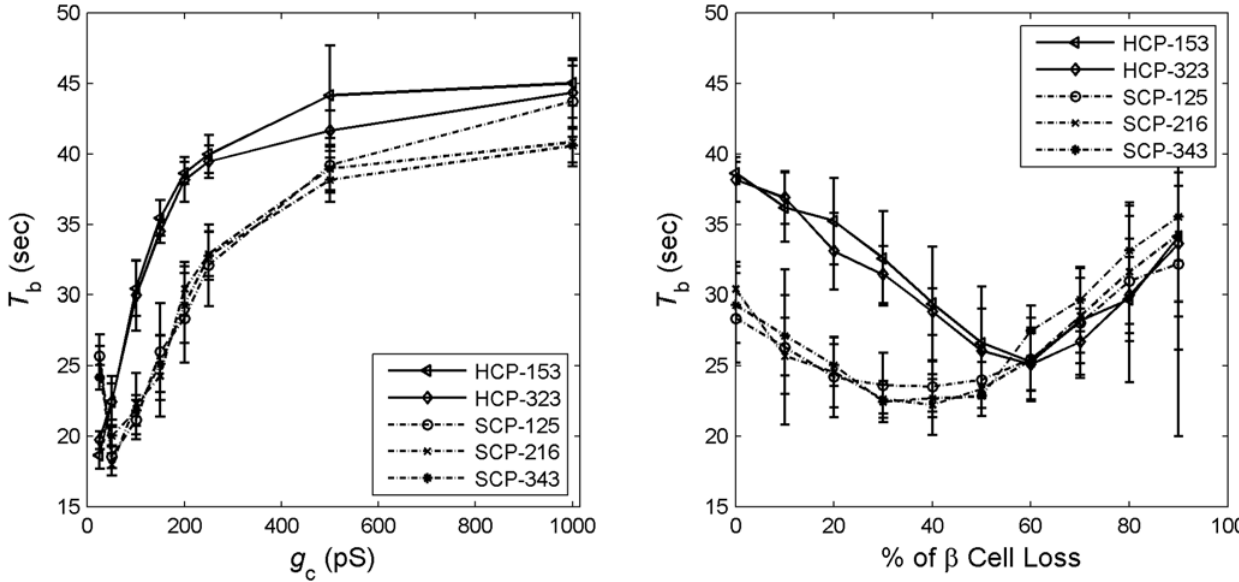
Figure 4. Comparison of the bursting period T b between HCP and SCP b -cell clusters.